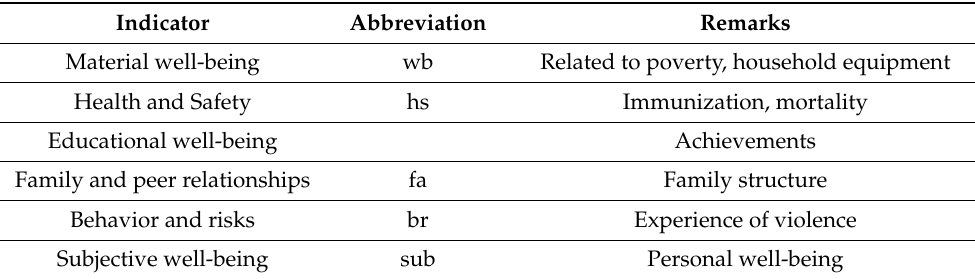
Table 1. Indicators of the UNICEF study concerning child well-being 1 .